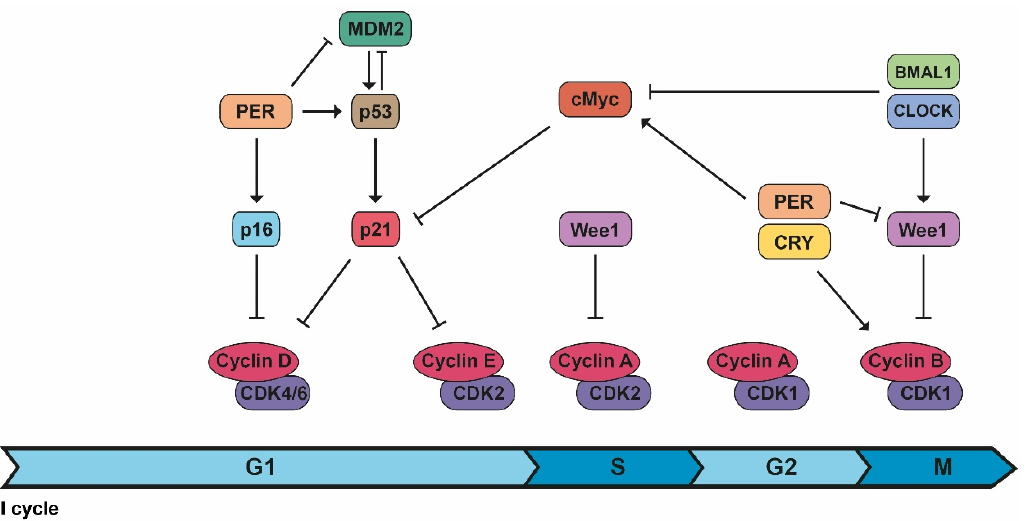
Figure 3. The connection between cell cycle and the molecular circadian clock. The machinery of the cell cycle is controlled by different components of the biological clock in different phases of the cell cycle.